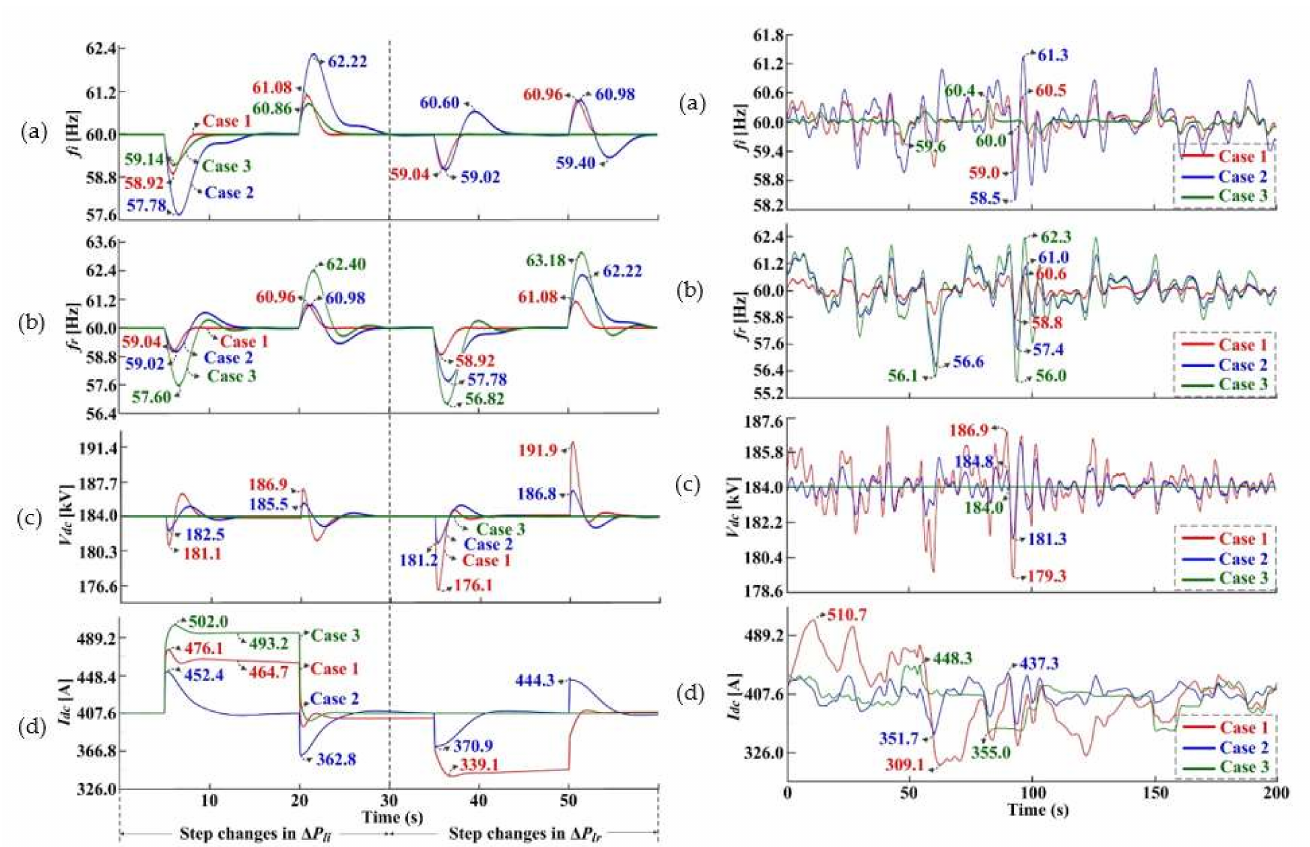
Figure 4. Responses to ( left ) step and ( right ) continuous variations in the inverter-side and rectifier- side loads and in the OWF power generation when the LQG strategy (Case 1) and conventional PI-based strategies (Cases 2 and 3) are applied: ( a ) inverter-side frequency f i , ( b ) rectifier-side